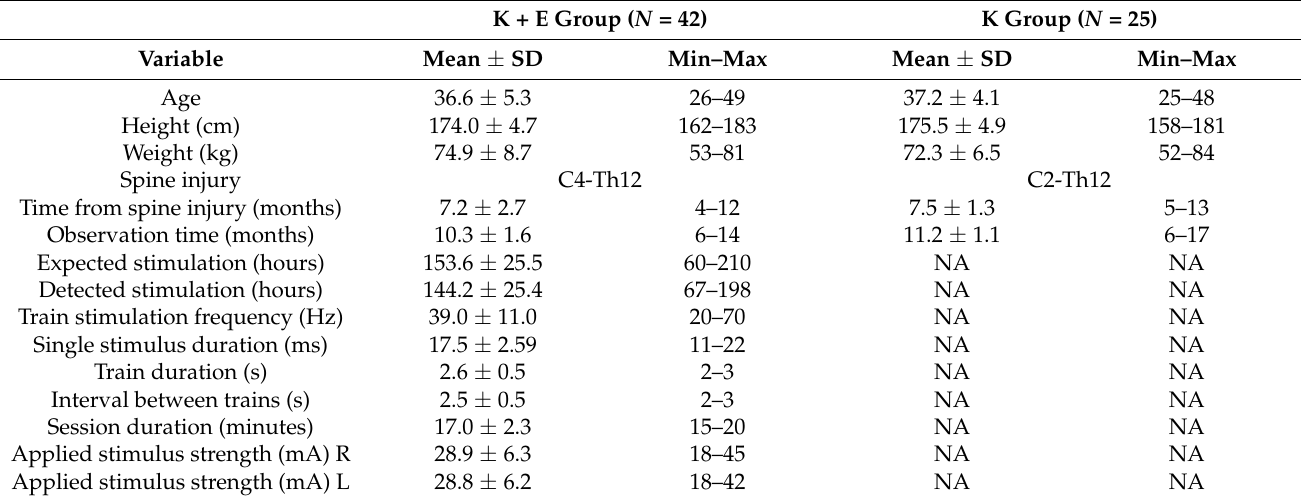
Table 1. Characteristics of the subjects studied in two